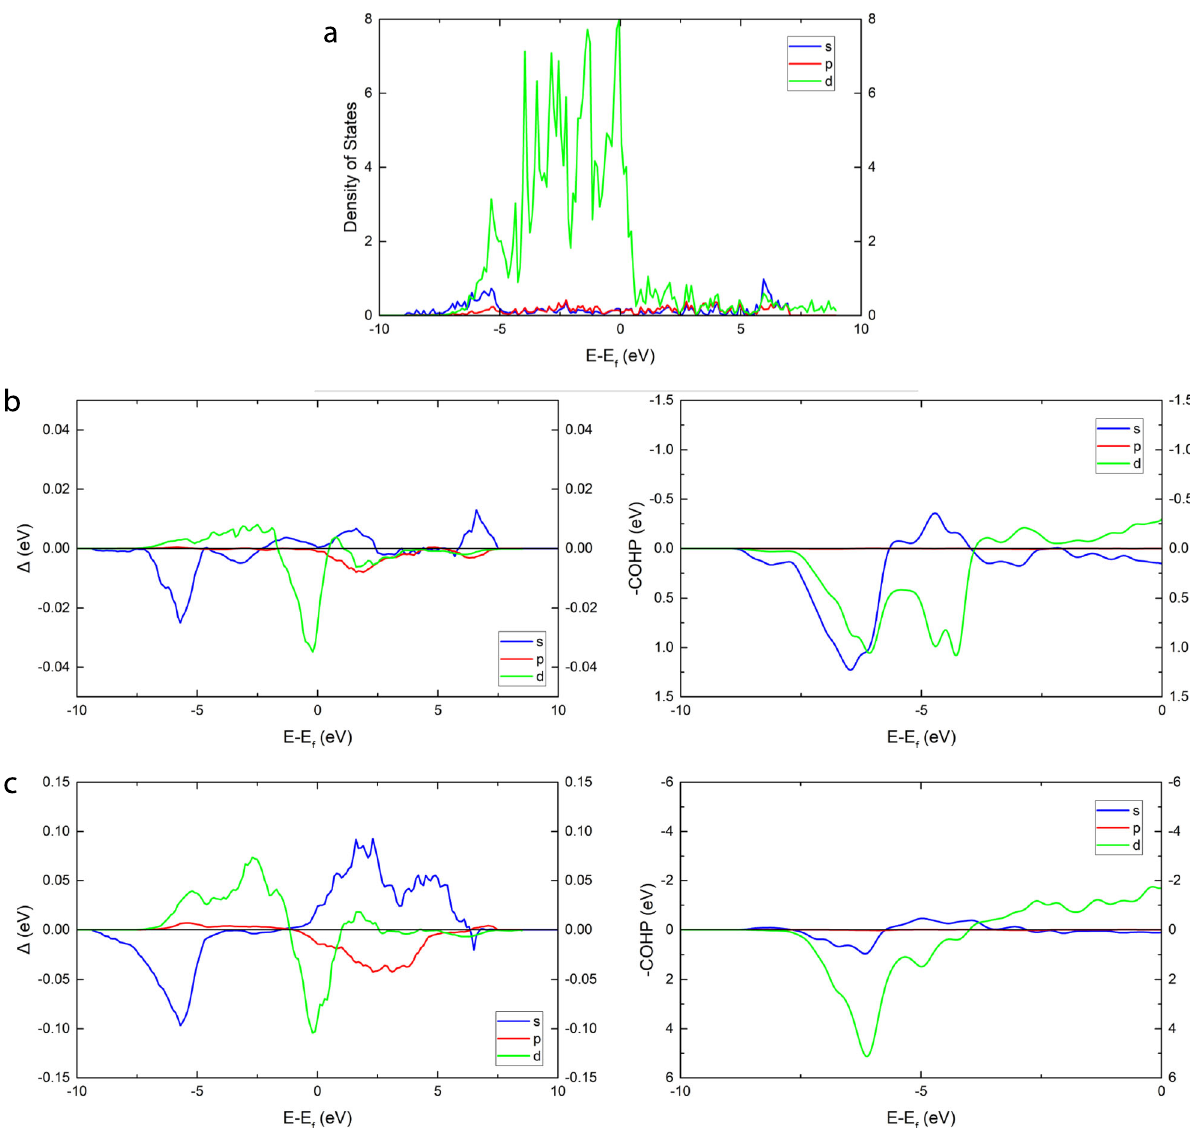
Fig. 7 Occlusion sensitivity for predicted adsorption energy. a Density of states of the Pt hollow site. Occlusion sensitivity Δ , for b hydrogen adsorption and c oxygen adsorption on the Pt hollow site and crystal orbital Hamilton population (COHP) curves for the corresponding adsorbate surface